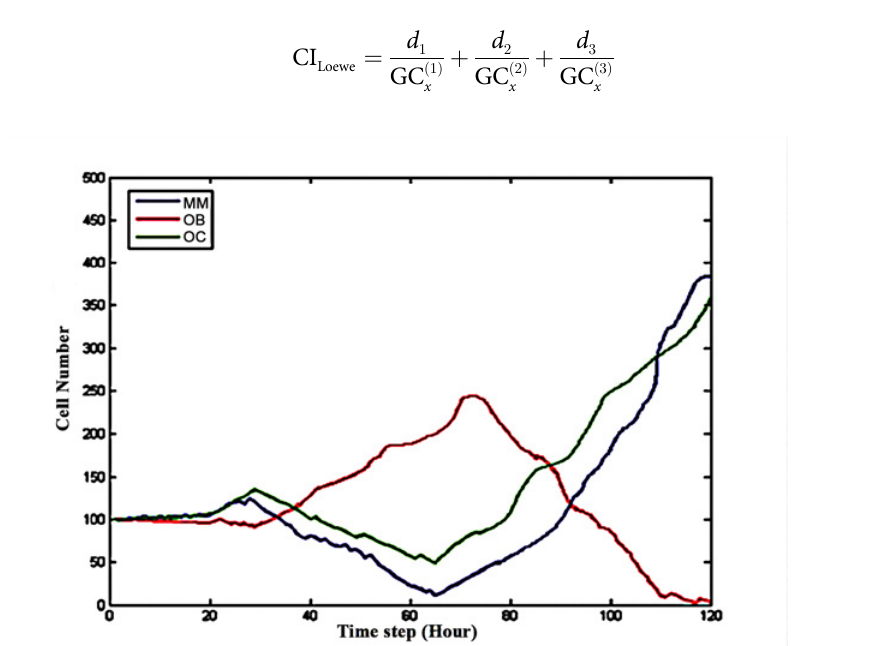
Fig 12. The effect of Lidamycin on the number of OBs, OCs and